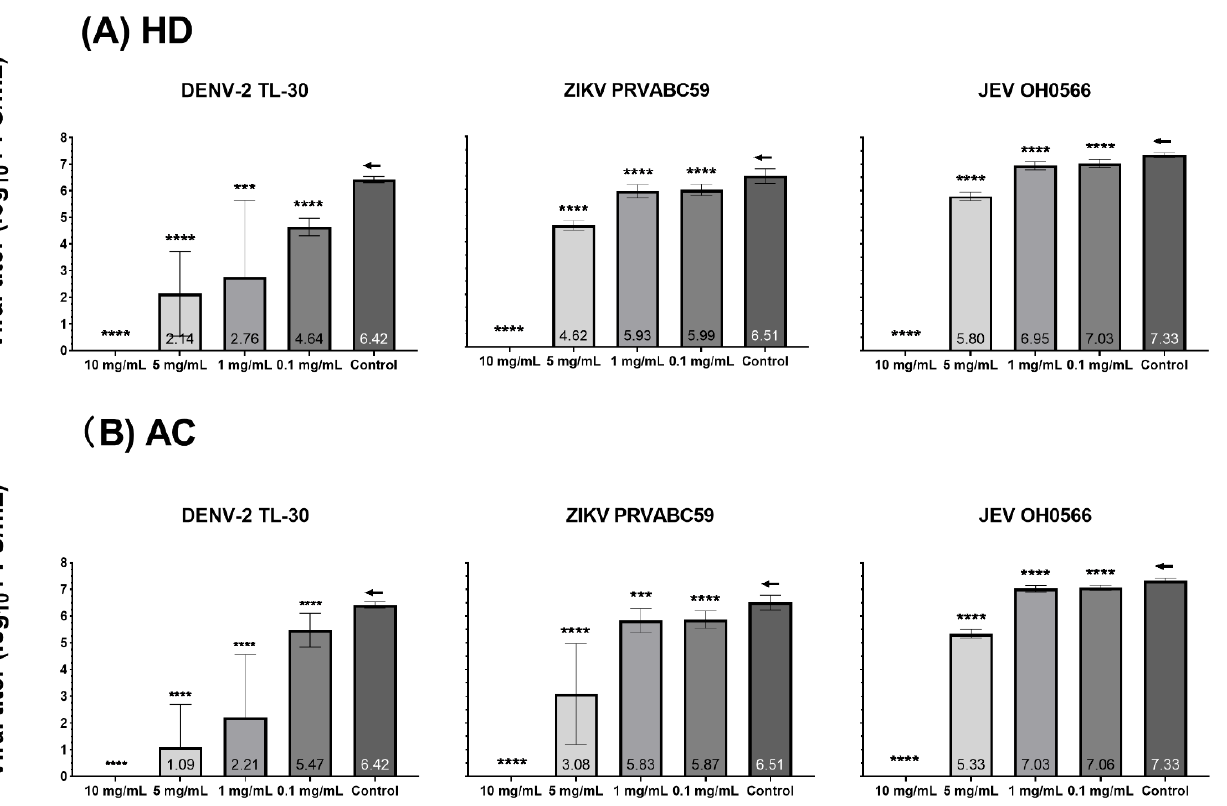
Figure 2. Inhibition effect of Hedyotis diffusa (HD) and Artemisia capillaris (AC) on DENV-2 TL-30, ZIKV PRVABC59, and JEV OH0566 viral replication via plaque reduction assay. Vero 9013 cells were incubated with each virus at MOI 0.01 for 1 h, and the unbound virus was removed by washing with EMEM to synchronize the replication, then treated with each herb at a range of concentrations (10, 5, 1, and 0.1 mg/mL). Supernatants were collected to determine infectious viral titers at 72 h p.i. for JEV OH0566 and ZIKV PRVABC59 and 96 h p.i. for DENV-2 TL-30, respectively. Viral titers are expressed as mean ± standard deviation log 10 PFU/mL. ( A ) Viral titer analysis following HD treatment. ( B ) Inhibition in AC treated samples. Viral titers were titrated using Vero 9013 cells. All experiments were performed using duodecuplicate (12 copies). ← : control; *p < 0.05; ** p < 0.01; *** p < 0.001; **** p < 0.0001; and ns indicates a p value of over 0.05 (p > 0.05).